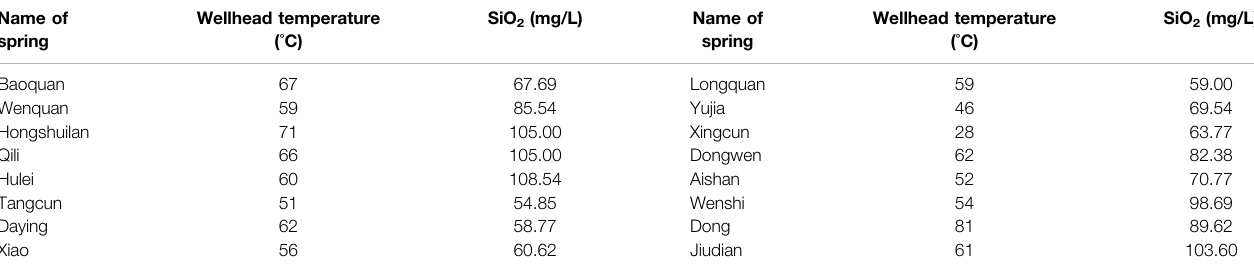
TABLE 1 | Wellhead temperature and SiO 2 concentration of the hot springs in the Jiaodong Peninsula. Name of